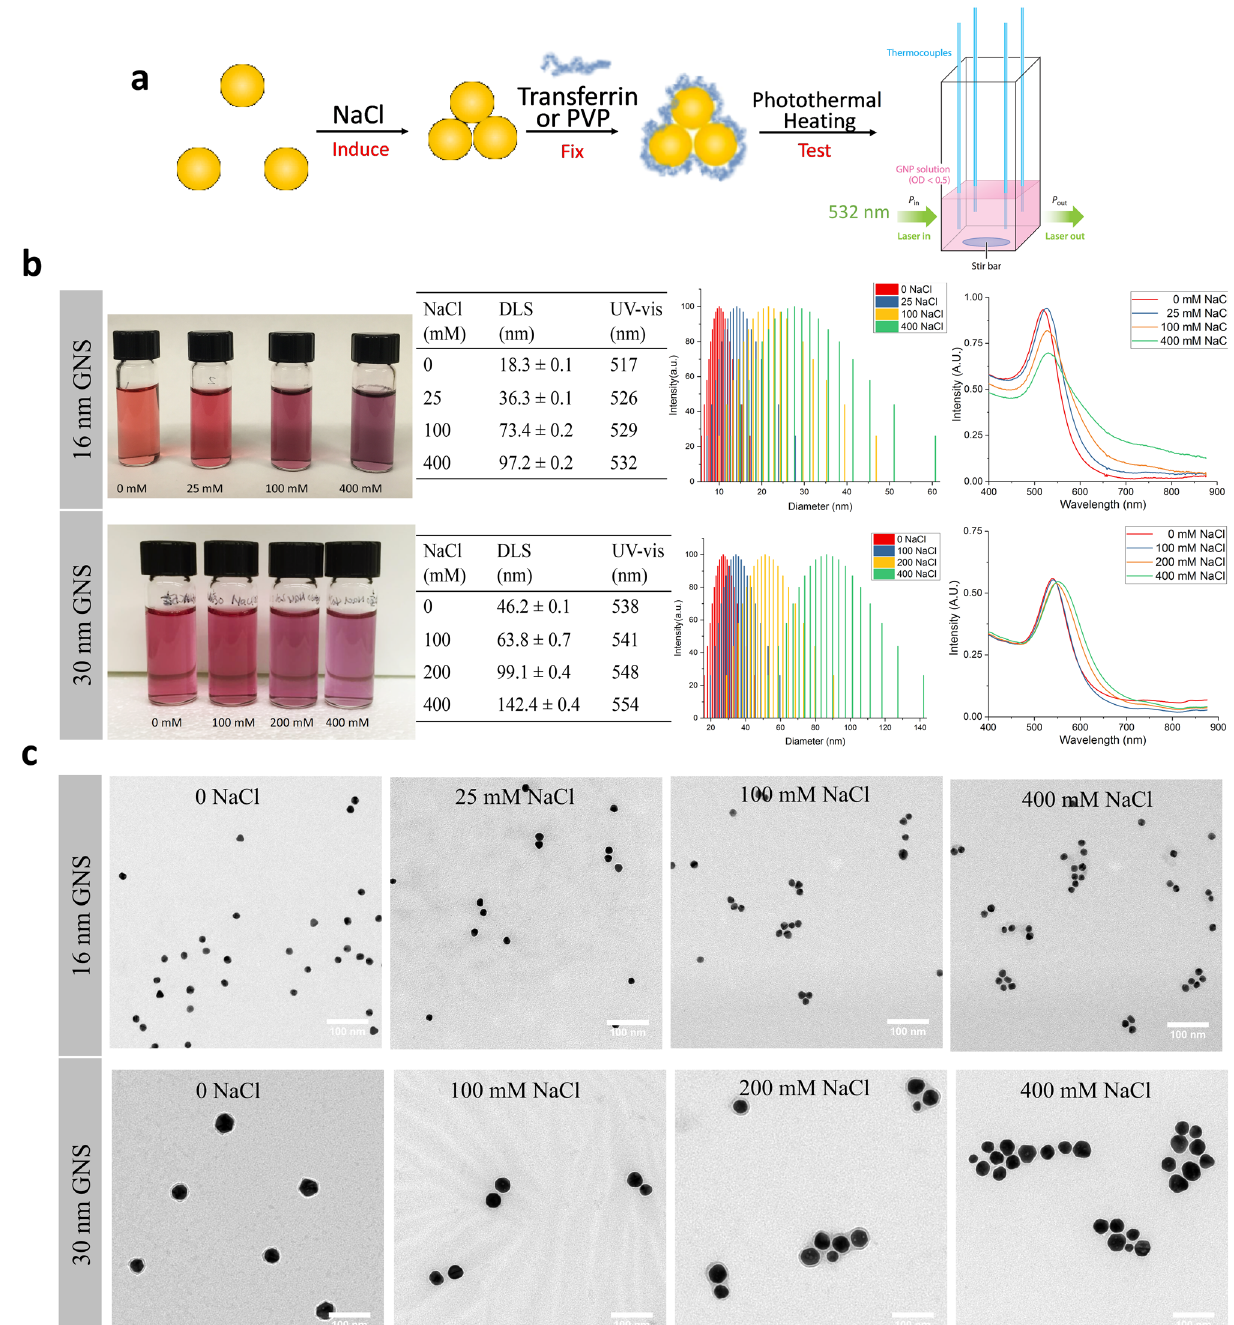
Figure 3. GNP aggregation photothermal conversion experiment preparation. ( a ) Experiment scheme: induce and fix controlled-size GNP aggregation in solution and test by cuvette settings. ( b ) Visual picture, DLS and UV–Vis characterization of GNP aggregation solutions. ( c ) TEM Characterization of GNP aggregation solution samples in ( b ), 100 nm scale